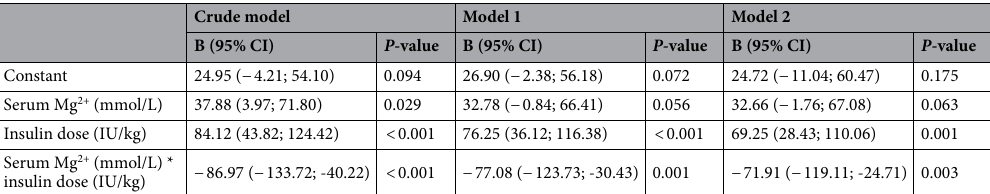
Table 2. Interaction effect of the moderator insulin dose and serum Mg 2+ associated with HbA 1c . Model 1 is age- and sex adjusted. Model 2 is adjusted for duration of diabetes (years), eGFR (< 60, 60–90, > 60 mL/ min/1.73m 2 ), alcohol use (yes/no), smoking (current, former, never), SBP (mmHg), TG (mmol/L), LDL cholesterol (mmol/L), statins (yes/no) and PPI (yes/no) drugs. eGFR = estimated glomerular filtration rate, LDL = low-density lipoprotein, Mg 2+ = magnesium, PPI = proton pump inhibitor, SBP = systolic blood pressure, TG = triglycerides.